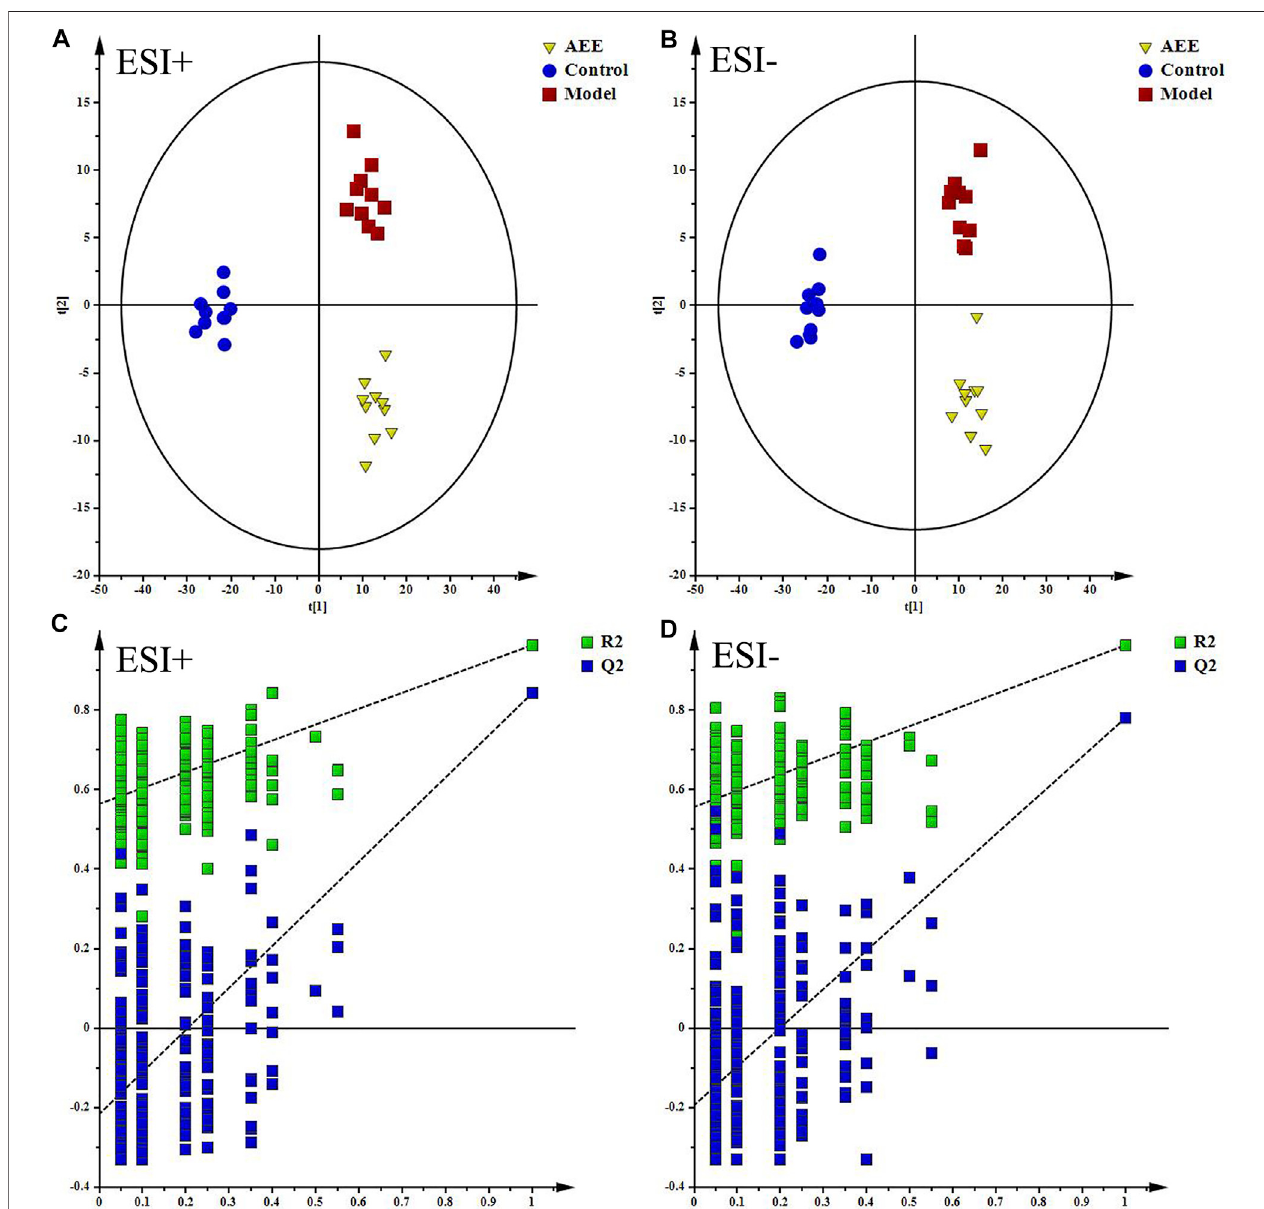
FIGURE2| EffectofAEEonmetabolomicpro fi leoffecesinhamsterfedwithhighfeddiet. (A,B) PLS-DAscoreplotsoffecessamplescollectedfromdifferenttreatment groups, ESI+: R 2 X (cid:1) 0.5, R 2 Y (cid:1) 0.974, and Q 2 (cid:1) 0.889; ESI − : R 2 X (cid:1) 0.524, R 2 Y (cid:1) 0.973, and Q 2 (cid:1) 0.837. (C,D) Permutation test of PLS-DA models in ESI+ and ESI − .